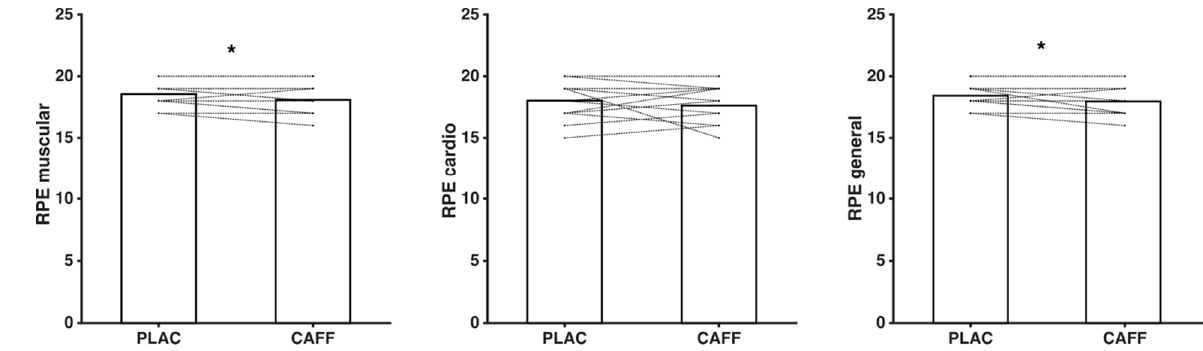
Figure 3. Rate of perceived exertion (RPE) (points) values observed at RPE muscular , RPE cardio , and RPE general recorded under placebo and caffeine experimental conditions. PLAC: placebo group; CAFF: caffeine supplementation group. * Significant difference for placebo vs. caffeine ( p < 0.05).